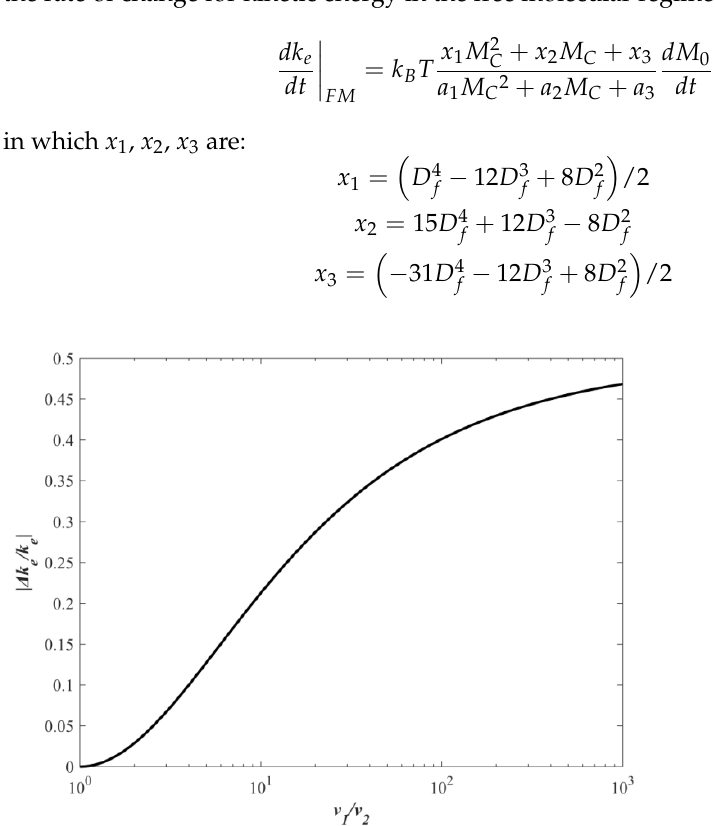
Figure 1. The relationship between | Δk e /k e | and υ 1 /υ